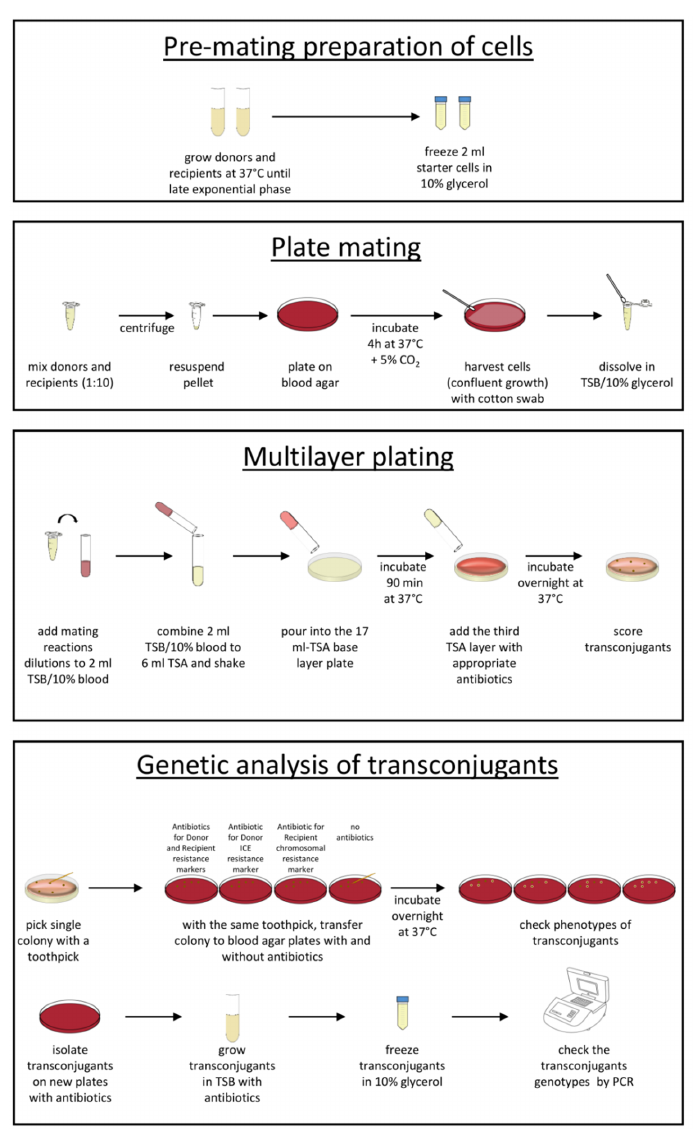
Figure 1. Schematic representation of the plate mating protocol for ICEs conjugal transfer in strep- tococci and enterococci .